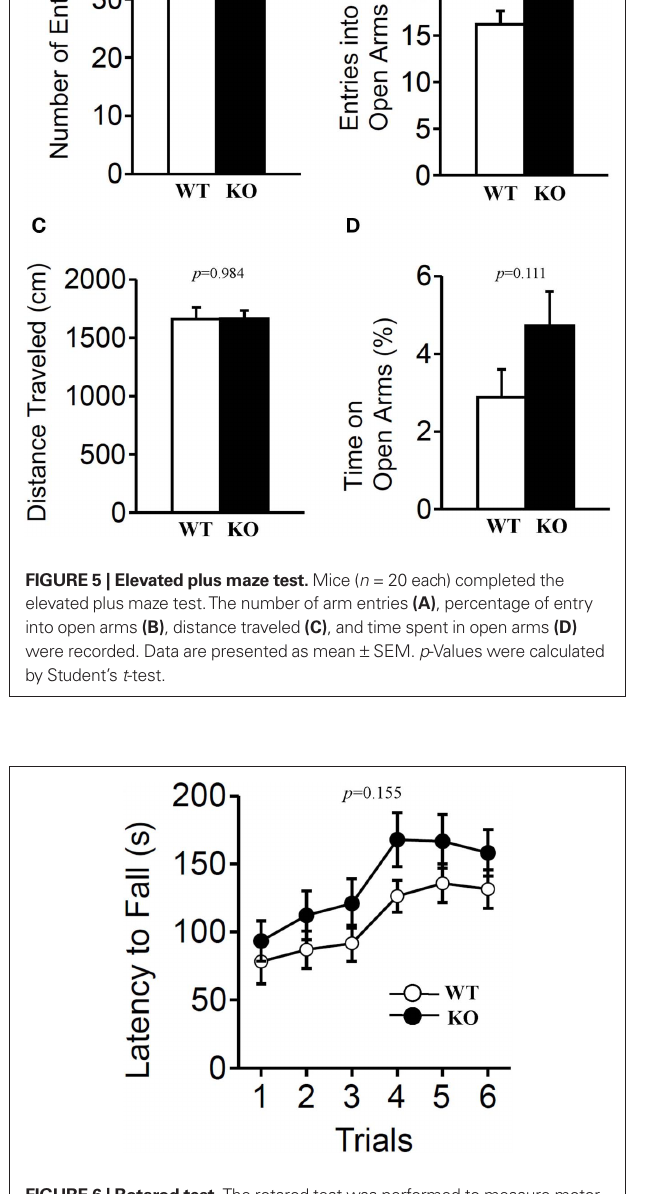
Figure 6 | rotarod test. The rotarod test was performed to measure motor function of wild-type (WT) and relaxin-3 KO (KO) mice. The latency to fall from an accelerating rotarod was measured in three trials per day. Data are presented as mean ± SEM ( n = 20 each). p -Values indicate significance of genotype effect in two-way repeated measures ANOVA.